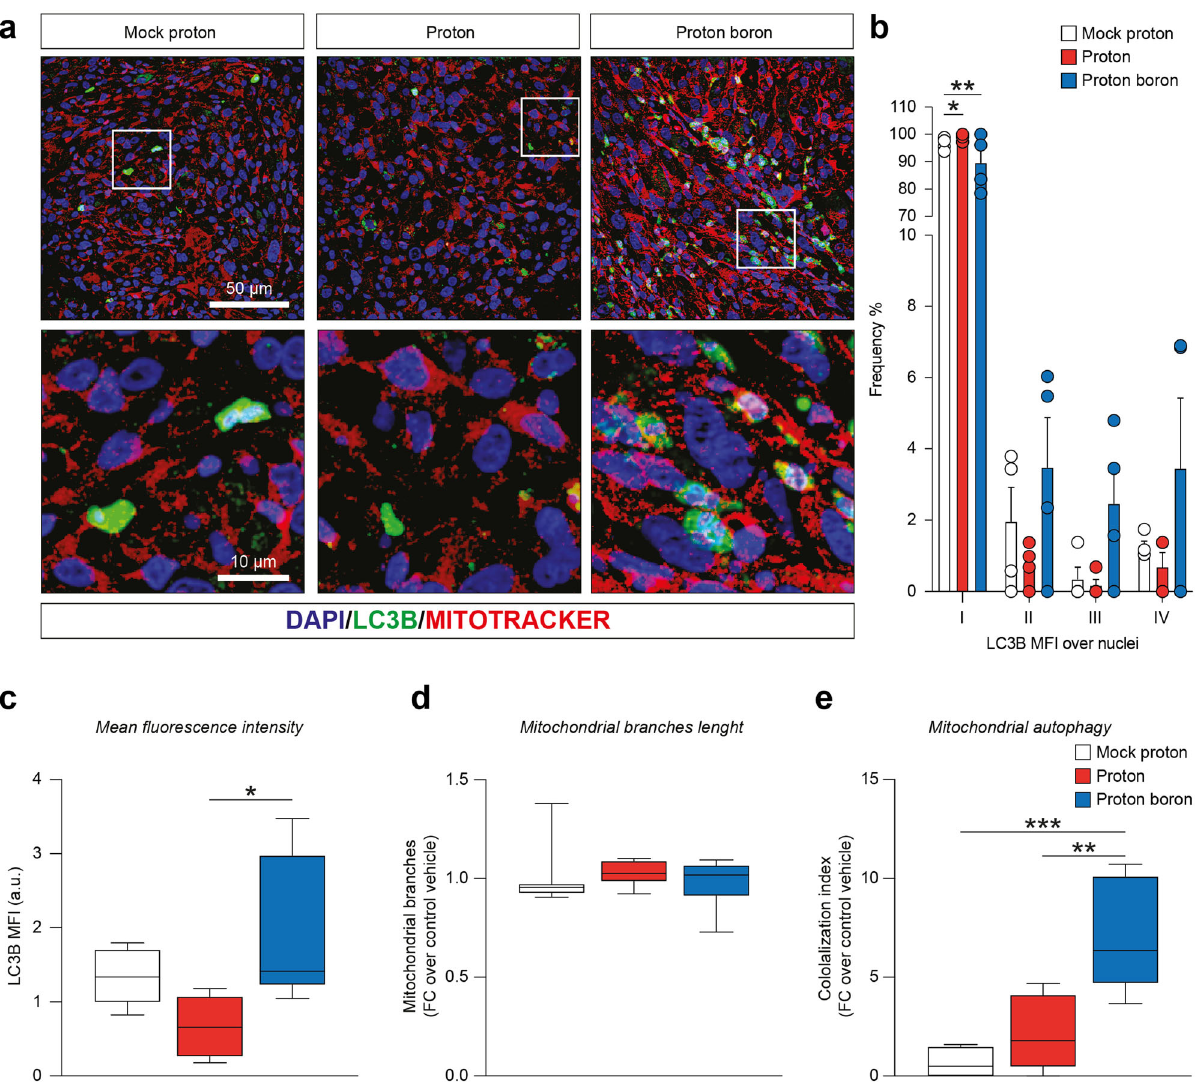
Fig. 5 PCBT increases the structural protein of autophagosomal membranes LC3B and mitophagy response. a Representative confocal-assisted immuno fl uorescence pictures of LC3B and mitotraker in GBM tumor sections derived from mock proton, proton-treated and proton boron-treated mice; b – e Quanti fi cation of the intensity range (I and II = low; III = medium; IV = high) frequency of LC3B, LC3B MFI cells, mitochondrial branches and LC3B/ mitotraker colocalization in GBM tumor sections derived from mock proton (white dots and white boxes), proton-treated (red dots and red boxes) and proton boron-treated mice (blue dots and blue boxes). * p -value < 0.05, ** p -value < 0.01, *** p -value <